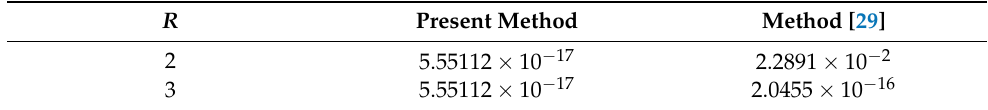
Figure 5. Plot of approximate and exact solutions of Examples 2 and 4. Table 2. Comparision of MAEs for Example 2 with the method proposed in [29] for different values of R .